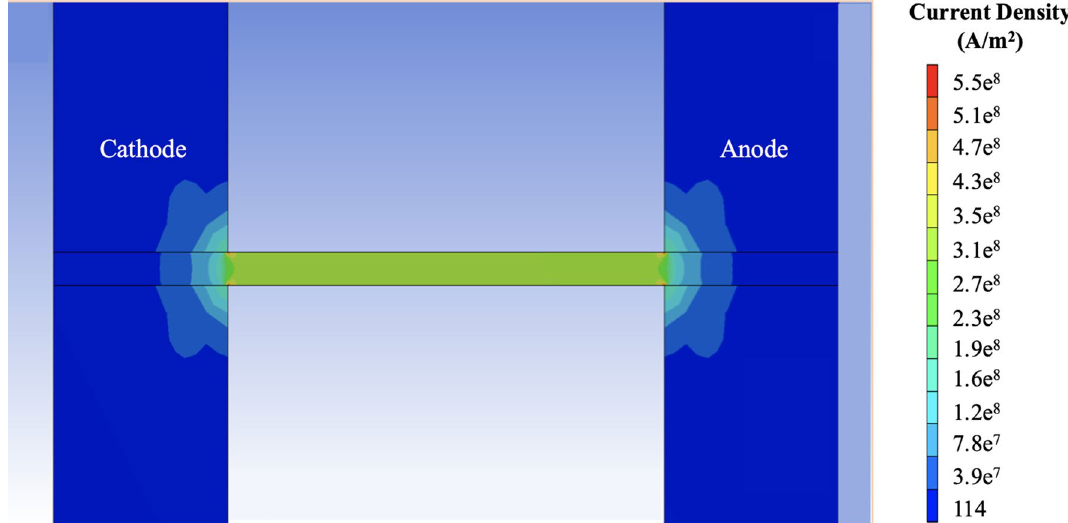
Figure 2. Current density distribution of the